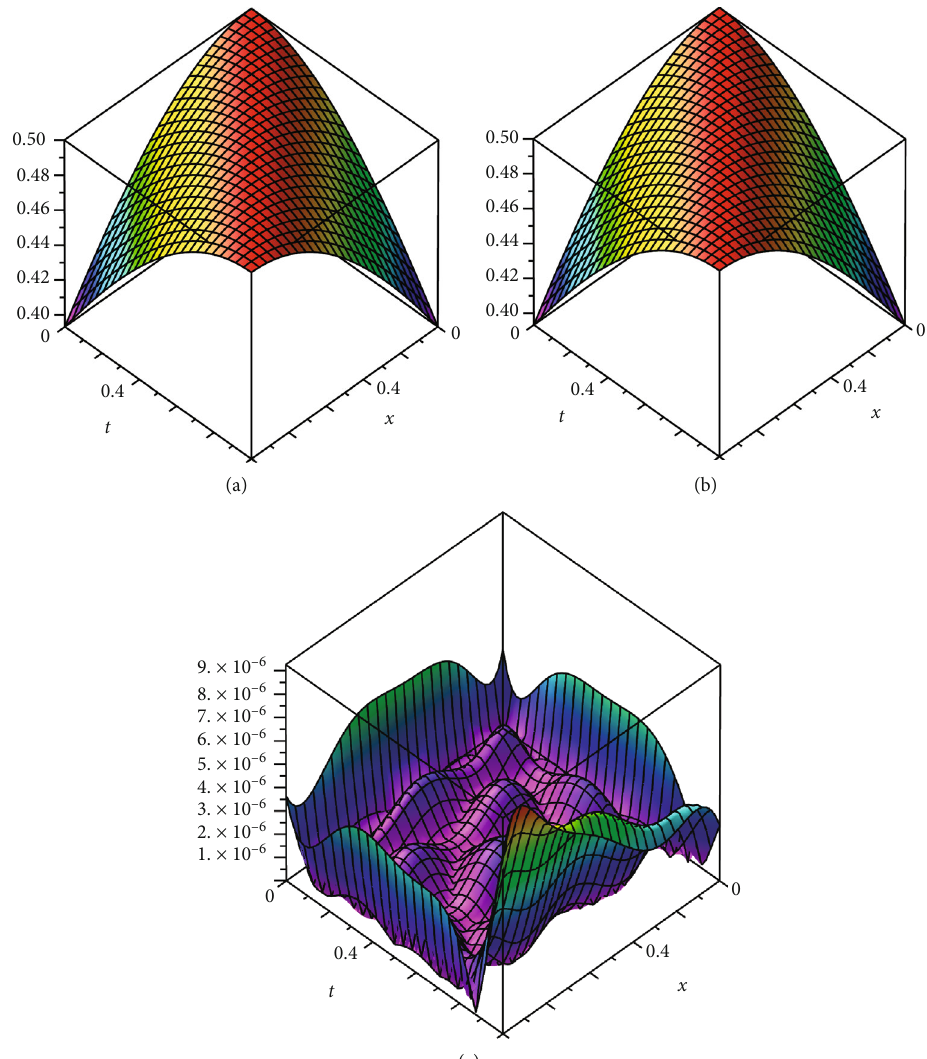
= k = 1, M = M = 5, and μ = 1 for Example 1 2 1 2